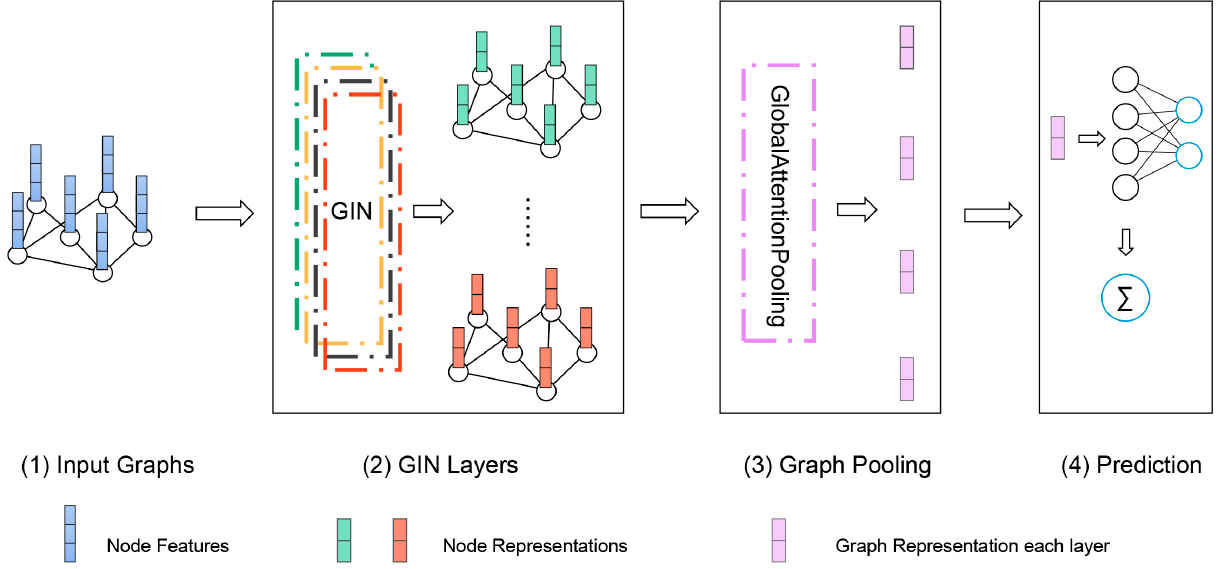
Figure 2. Illustration of our proposed GIN which included four steps, (1) input graphs that corre- sponds to different subjects; (2) learn node representation through GIN Layers, generating a new representation for each layer; (3) turn the node representations of all layers into the representation of the whole graph by pooling; (4) input graph representation for linear prediction.